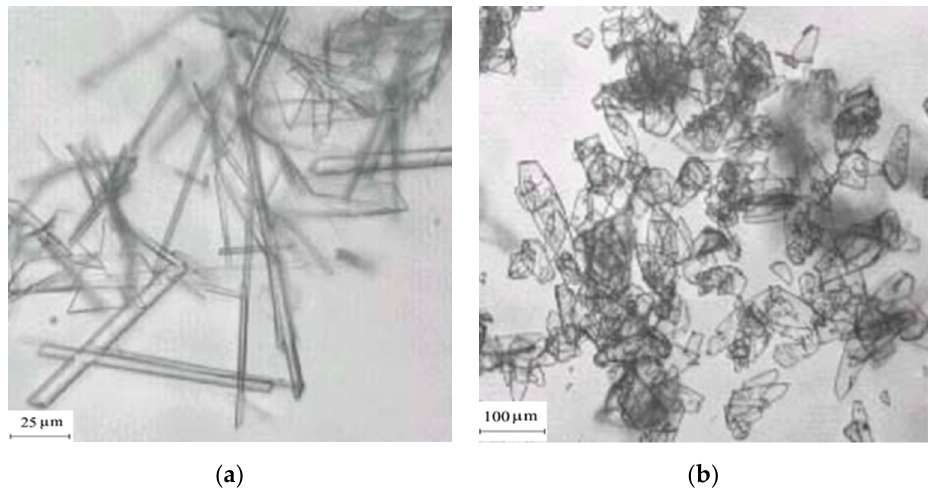
Figure 8. XRD analysis on solid precipitate.